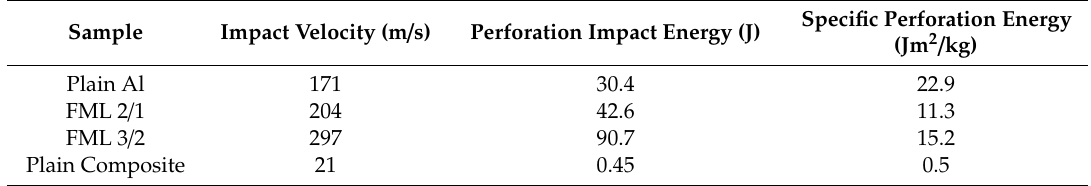
Table 3. High velocity impact test results of the FMLs and its constituent materials.